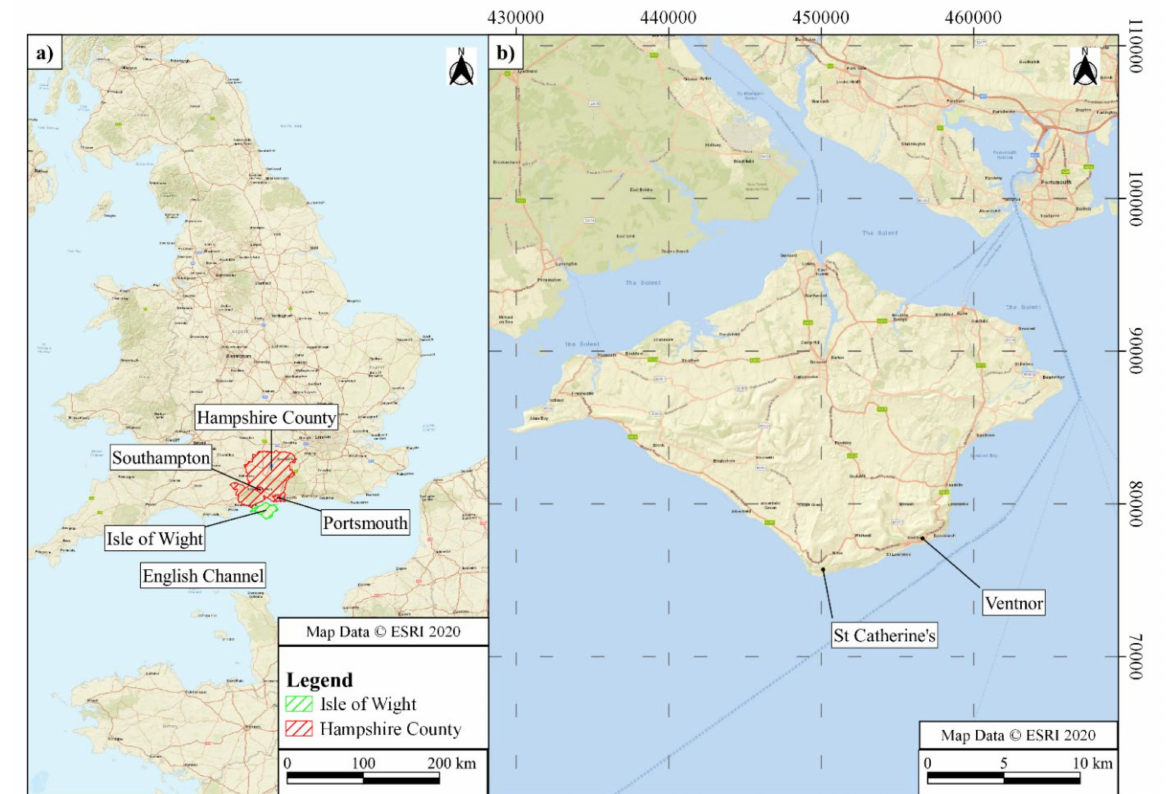
Figure 1. Location of the Isle of Wight in relation to Great Britain ( a ) and the location of Ventnor on the Isle of Wight ( b ). Image created on QGIS with background imagery from ESRI World Street Map (Service Layer Credits: Esri, DeLorme, HERE, USGS, Intermap, iPC, NRCAN, Esri Japan, METI, Esri China (Hong Kong), Esri (Thailand), MapmyIndia,